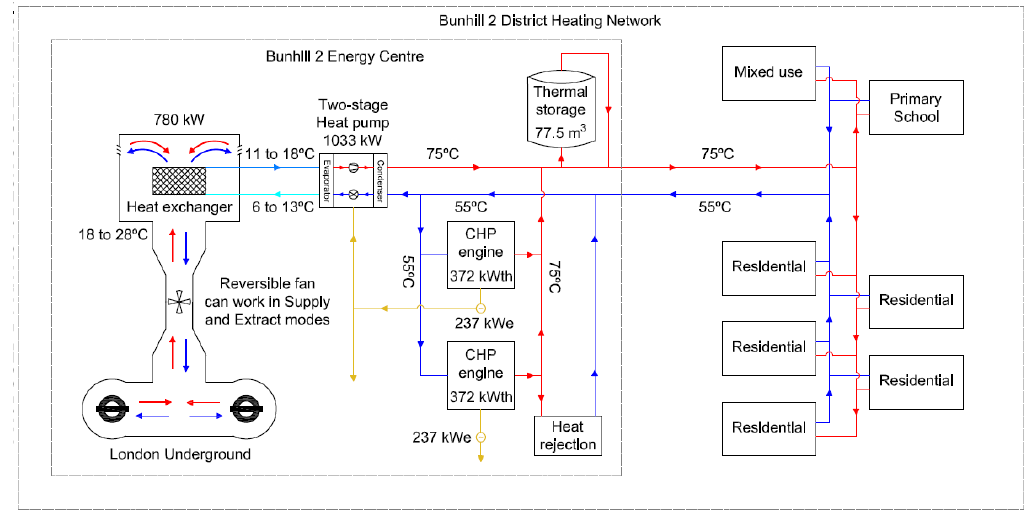
Figure 3. Schematic of the Bunhill Waste Heat Recovery System.